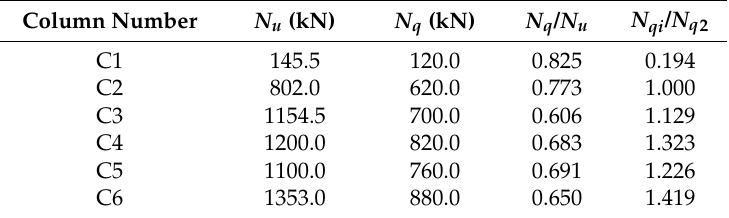
Table 6. Comparison of local-buckling load of